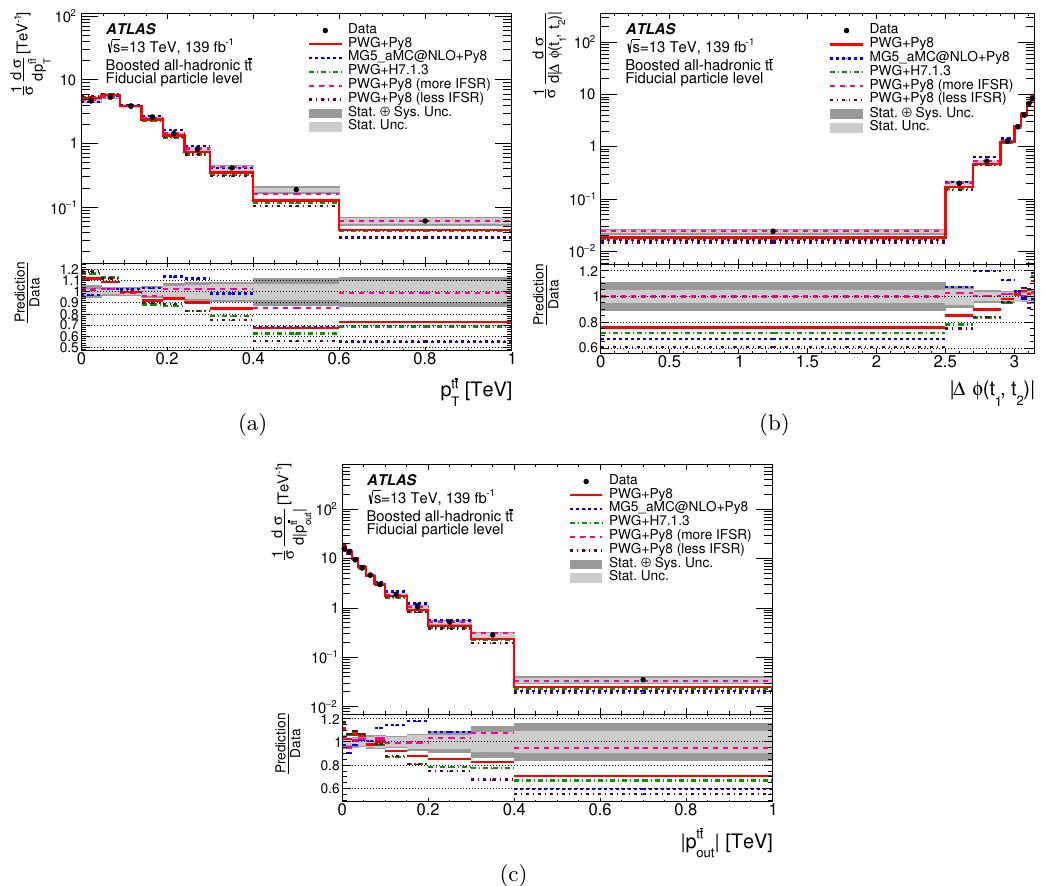
Figure 12 . Normalized particle-level fiducial phase-space differential cross-sections as a function of (a) the p T of the t ¯ t system, p t ¯ t , (b) the azimuthal angle between the two top-quark jets, ∆ φ t ¯ t , T and (c) the absolute value of the out-of-plane momentum, p t ¯ t . The dark and light grey bands out indicate the total uncertainty and the statistical uncertainty, respectively, of the data in each bin. Data points are placed at the centre of each bin. The Powheg+Pythia 8 MC sample is used as the nominal prediction to correct the data to particle